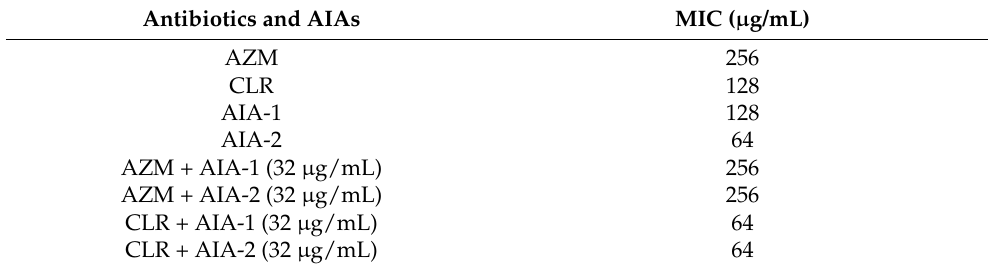
Table 1. Susceptibility to antibiotics and AIAs.